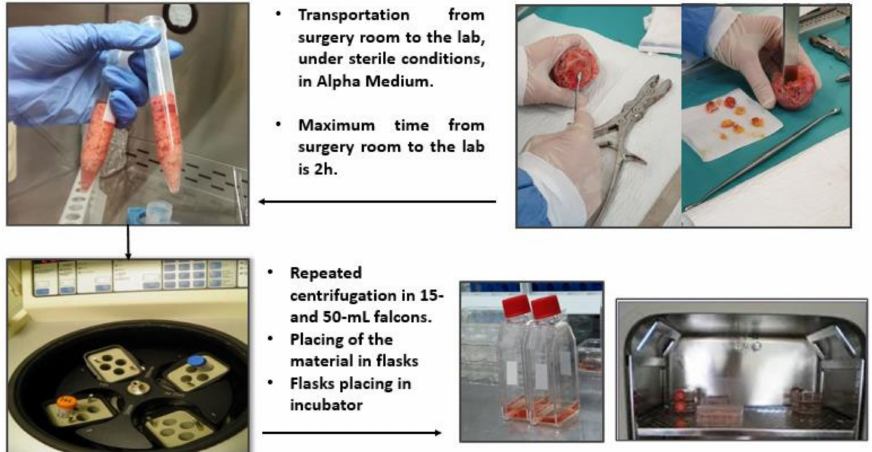
Figure 2. The schematic representation of steps involved in cells isolation: bone sectioning (up-right), bone deposition in 15 mL tubes (up-left), bone centrifugation (down-left) and medium with residual bone and extracted cells in flasks and in the incubator